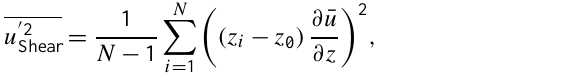
modulation in the mesospheric wind variances over Rothera (68 ◦ S, 68 ◦ W), which they attributed to GW/tidal